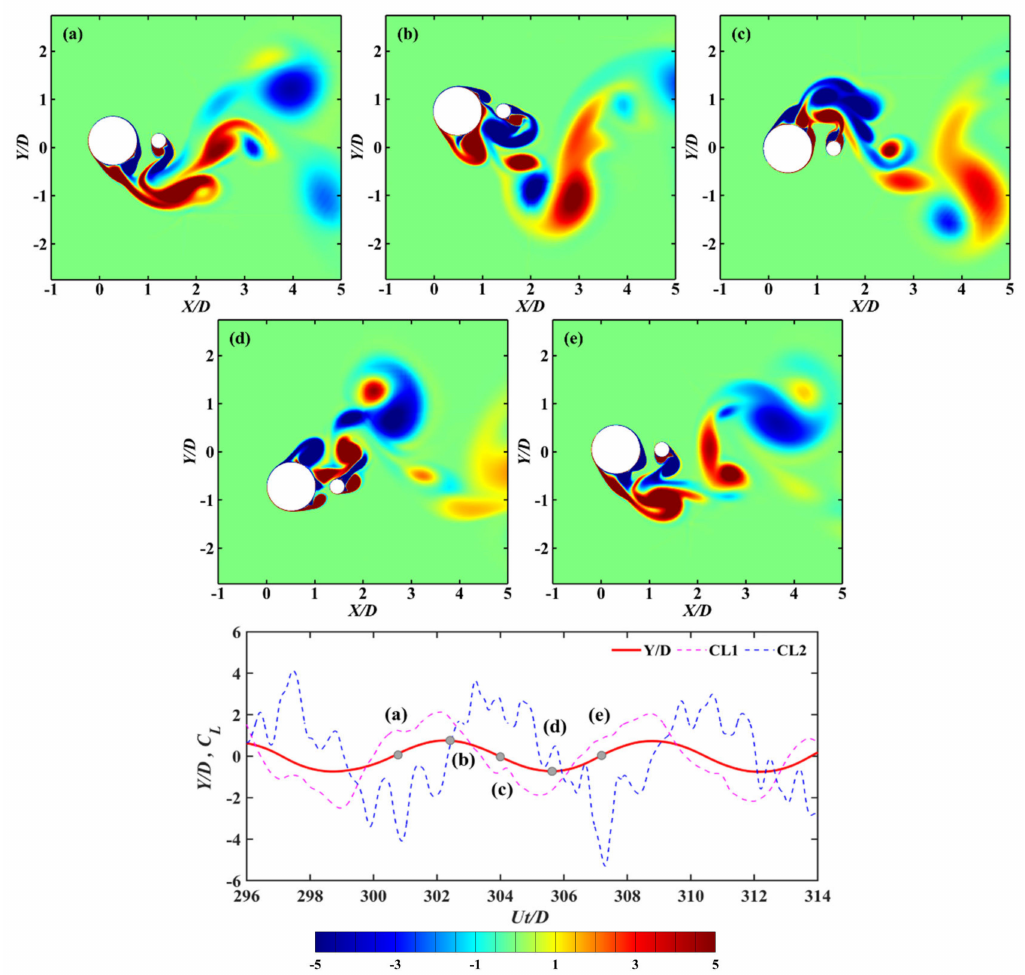
Figure 15. Instantaneous vorticity contours for the typical time instants in one vibration period at d/D = 0.3, α = 0 ◦ and U r = 5: ( a ) Ut/D = 300.8; ( b ) Ut/D = 302.4; ( c ) Ut/D = 304.0; ( d ) Ut/D = 305.6; ( e ) Ut/D =